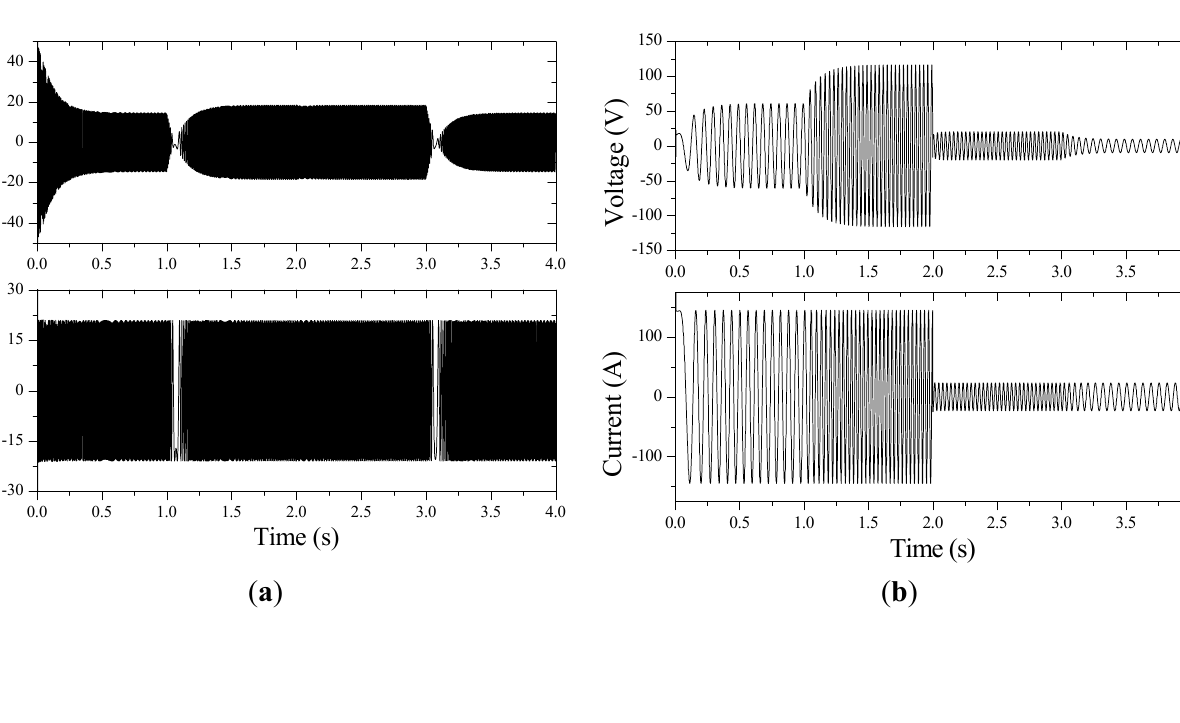
Figure 7. Phase voltage and current waveforms of DRM and motor-2: ( a ) DRM; ( b )